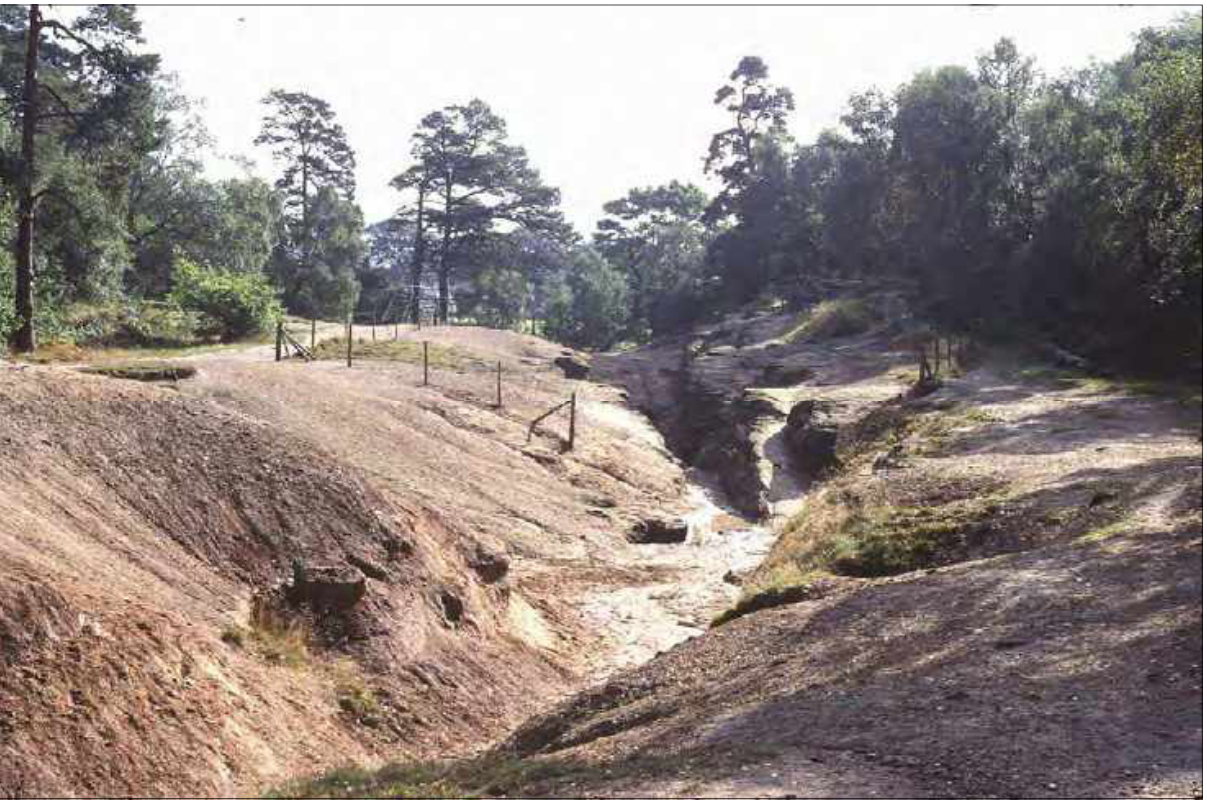
Fig 2.25 Part of the Alderley Edge copper mines complex, Cheshire (Cheshire County